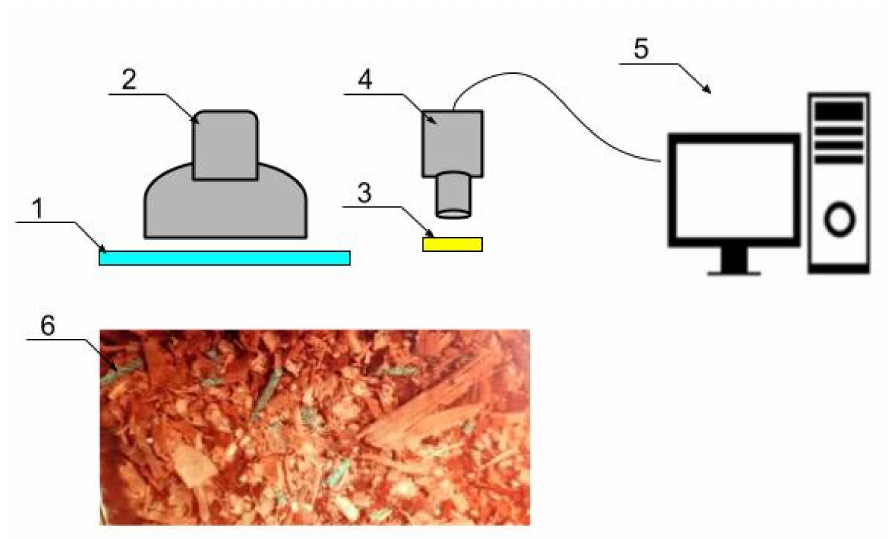
Figure 2. Schematic diagram of the experimental installation. 1—blue filter, 2—diode lamp, 3— yellow filter, 4—RGB camera, 5—computer with Matlab program, 6—sample image fixed through light